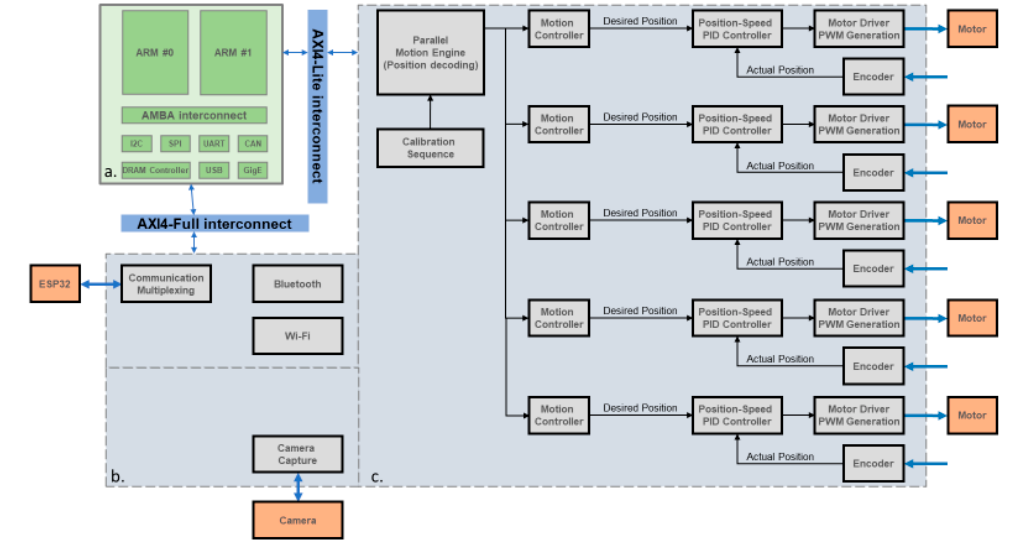
Figure 14. Hardware IP Controller. ( a ). Embedded dual core processor, ( b ). Communication hardware accelerator, ( c ). Hardware motion engine.